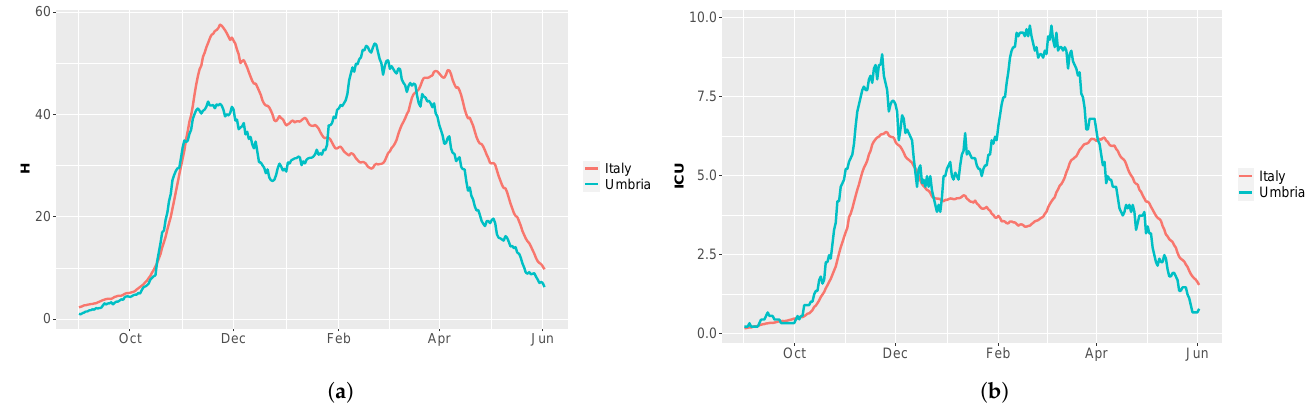
Figure 2. Comparison of hospitalization and ICU admissions in Umbria (light blue line) and Italy (red line) from 1 September until 1 May 2021. ( a ) Daily hospitalizations normalized over the whole population ( ∼ 882,000 for Umbria and ∼ 60 million for Italy) and multiplied by 10 5 . ( b ) Daily ICU admissions normalized over the whole population and multiplied by 10 5